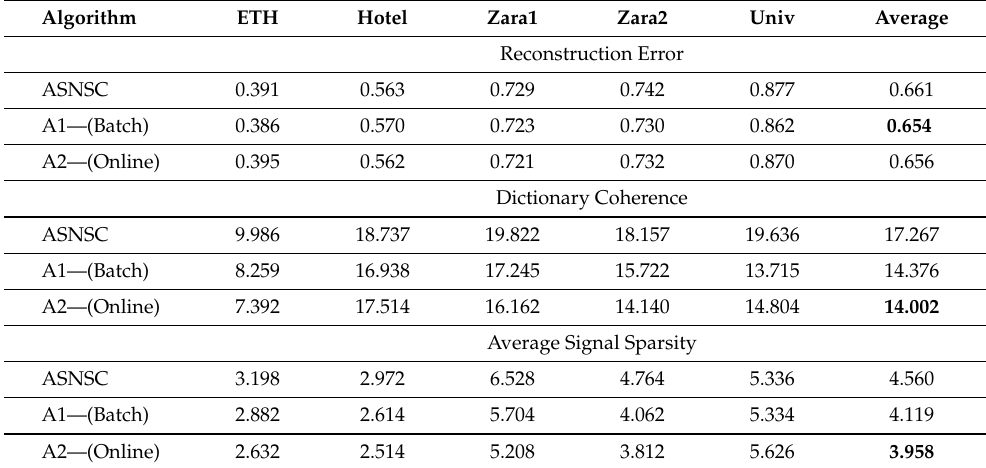
Table 1. Performance comparison between dictionaries learned by ASNSC [9], and the proposed algorithms A1 and A2. Lower is better.